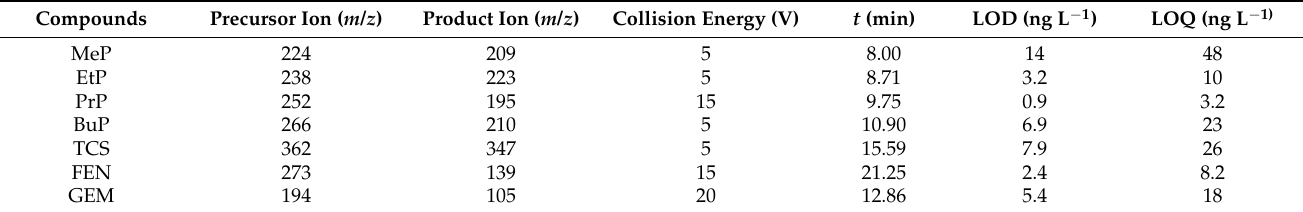
Table 1. Parameters for the chromatographic method.